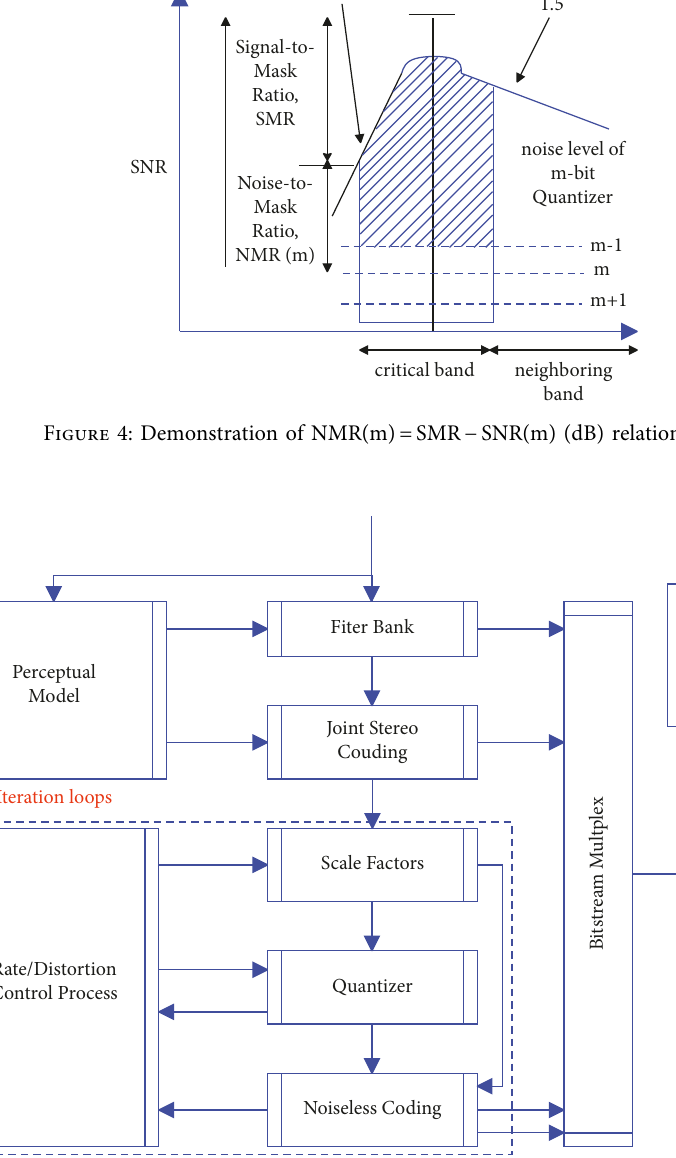
Figure 5: Block diagram of an encoder with dual cyclic rate-quality control.